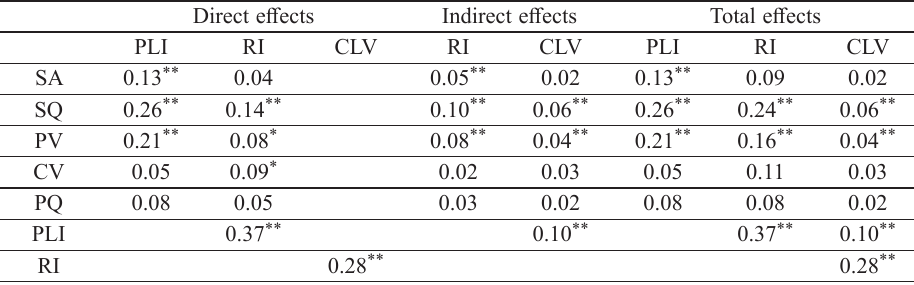
Table 3. Direct effects, indirect effects, and total effects